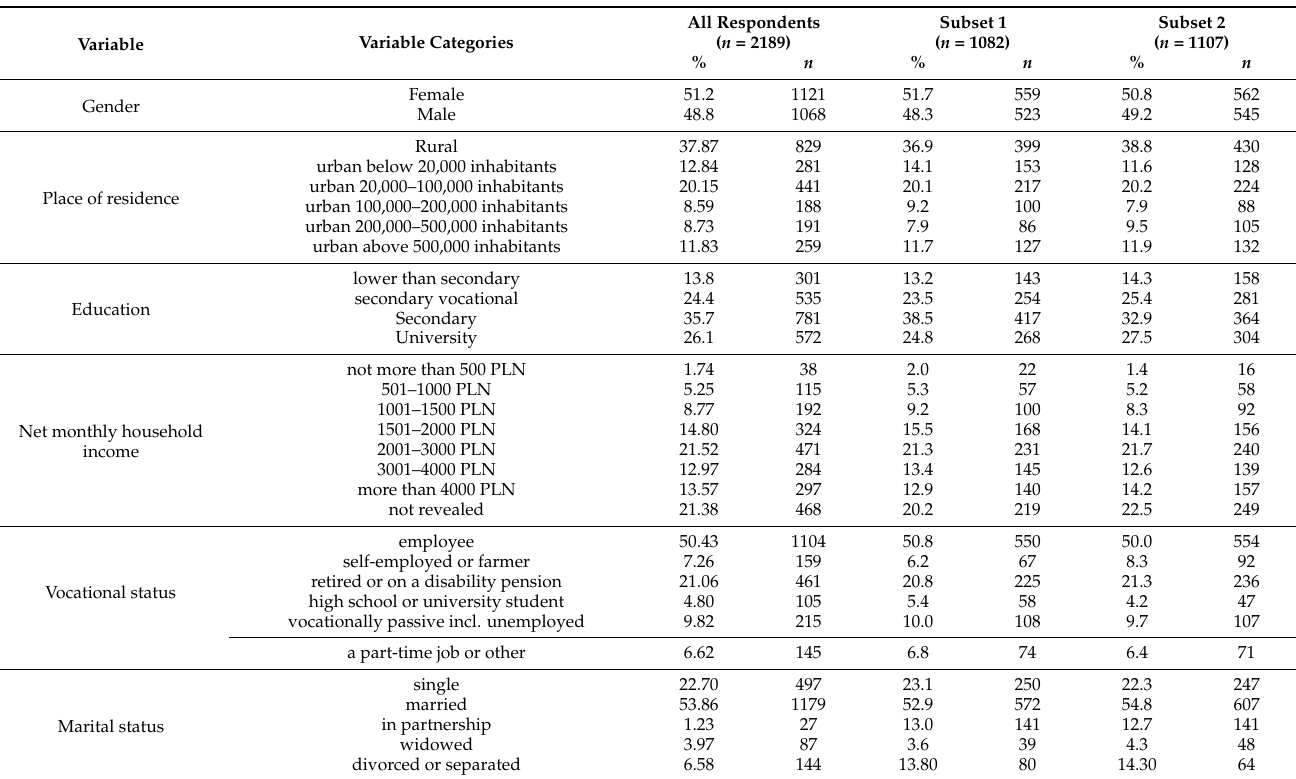
Table 1. Characteristics of the study sample and subsets used for the exploratory and confirmatory factor